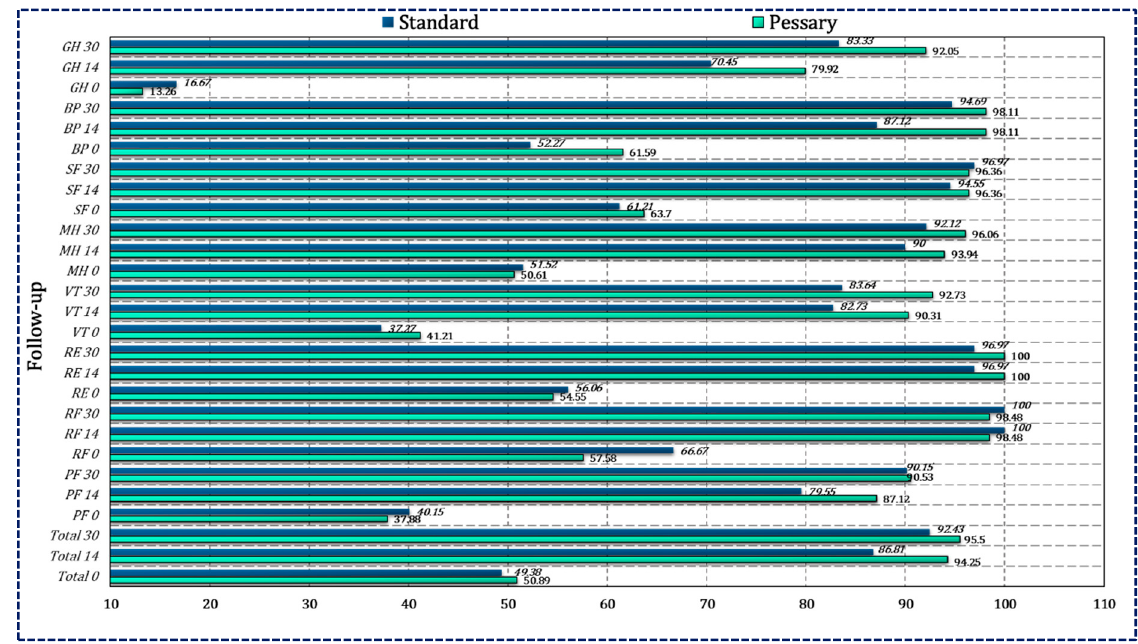
Figure 4. Comparative analysis between both standard and pessary groups based on SF-12 HRQoL at each follow-up.